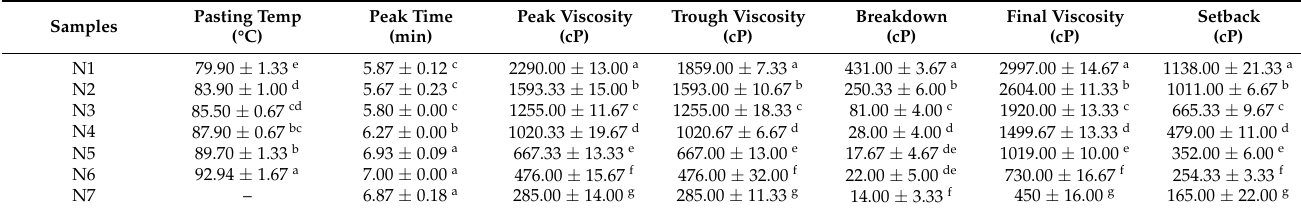
Table 1. Pasting parameters of noodle